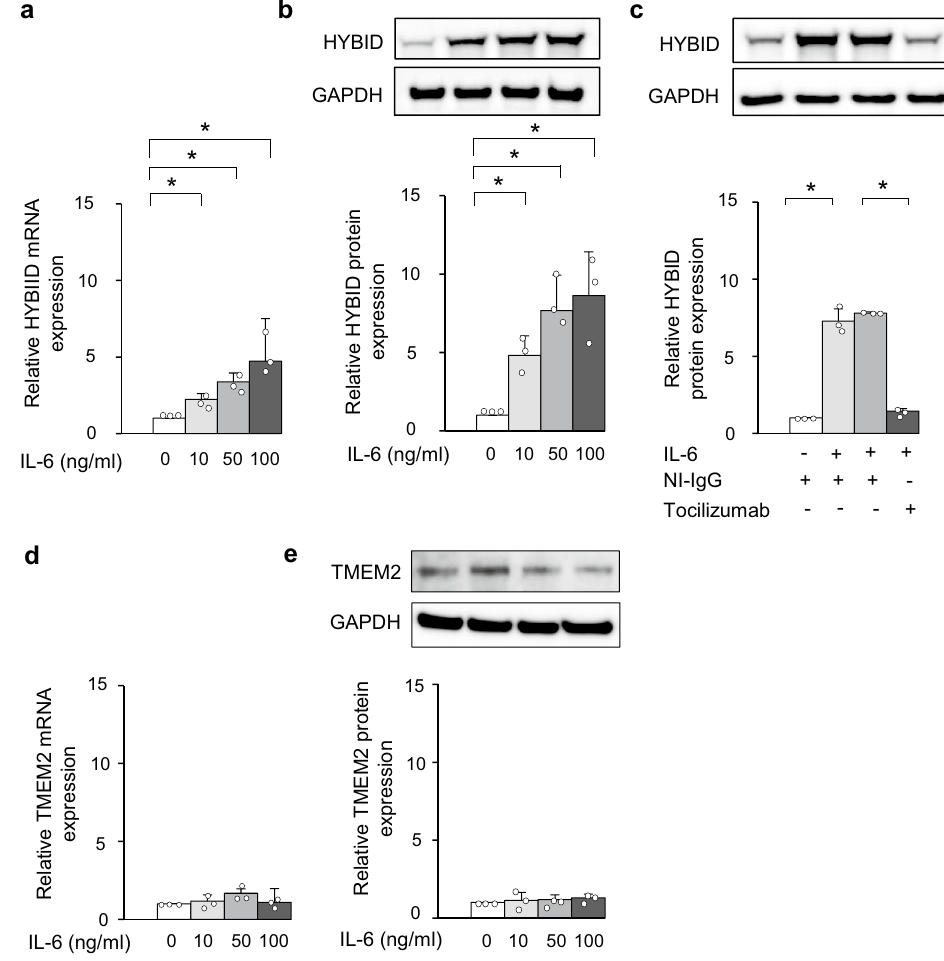
Figure 2. Increased HYBID expression by IL-6 in OA chondrocytes. ( a ) and ( b ) Effects of IL-6 on the mRNA and protein expression of HYBID in OA chondrocytes. OA chondrocytes at P2 were treated with IL-6 (0, 10, 50 or 100 ng/ml) and soluble IL-6 receptor (sIL-6R; 100 ng/ml). Cell lysates were harvested at 24 h after cultures for the HYBID mRNA expression and at 48 h for protein expression and subjected to quantitative real-time PCR using the ΔΔCt method ( a ) and immunoblotting with anti-HYBID antibody, followed by densitometric analysis ( b ). The average HYBID:GAPDH ratio in control OA chondrocytes treated with vehicle alone was set at 1. ( c ) Demonstration of IL-6-mediated HYBID protein overexpression in OA chondrocytes. OA chondrocytes at P2 were stimulated with IL-6 (0 or 100 ng/ml) and sIL-6R (100 ng/ml) in the presence of non-immune IgG (NI-IgG, 25 µg/ml) or anti-IL-6R antibody (tocilizumab, 25 µg/ml) for 48 h, and cell lysates were subjected to immunoblotting with anti-HYBID antibody, followed by densitometric analysis. ( d ) and ( e ) Effects of IL-6 on the mRNA and protein expression of TMEM2 in OA chondrocytes. OA chondrocytes at P2 were treated with IL-6 (0, 10, 50 or 100 ng/ml) and sIL-6R (100 ng/ml) for 24 h and 48 h, and TMEM2 expression was measured by quantitative real-time PCR using the ΔΔCt method ( d ) and immunoblotting, which was followed by densitometric analysis ( e ). The average TMEM2:GAPDH ratio in control OA chondrocytes treated with vehicle alone was set at 1. Values are expressed mean ± SD (n = 3). *, P < 0.05. The uncropped full-length gels can be found in Supplementary Figure